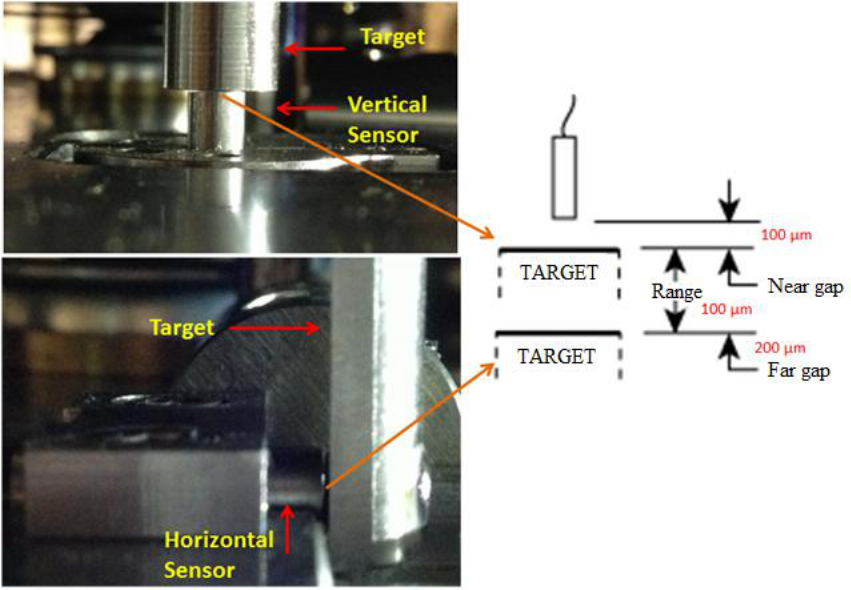
Figure 15. View of the capacitive sensors and targets with their operational working